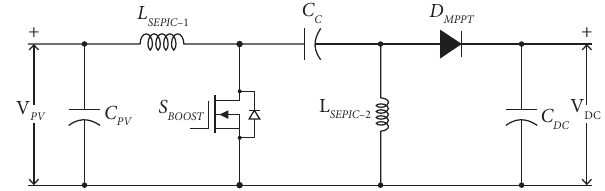
Figure 2: Te SEPIC converter